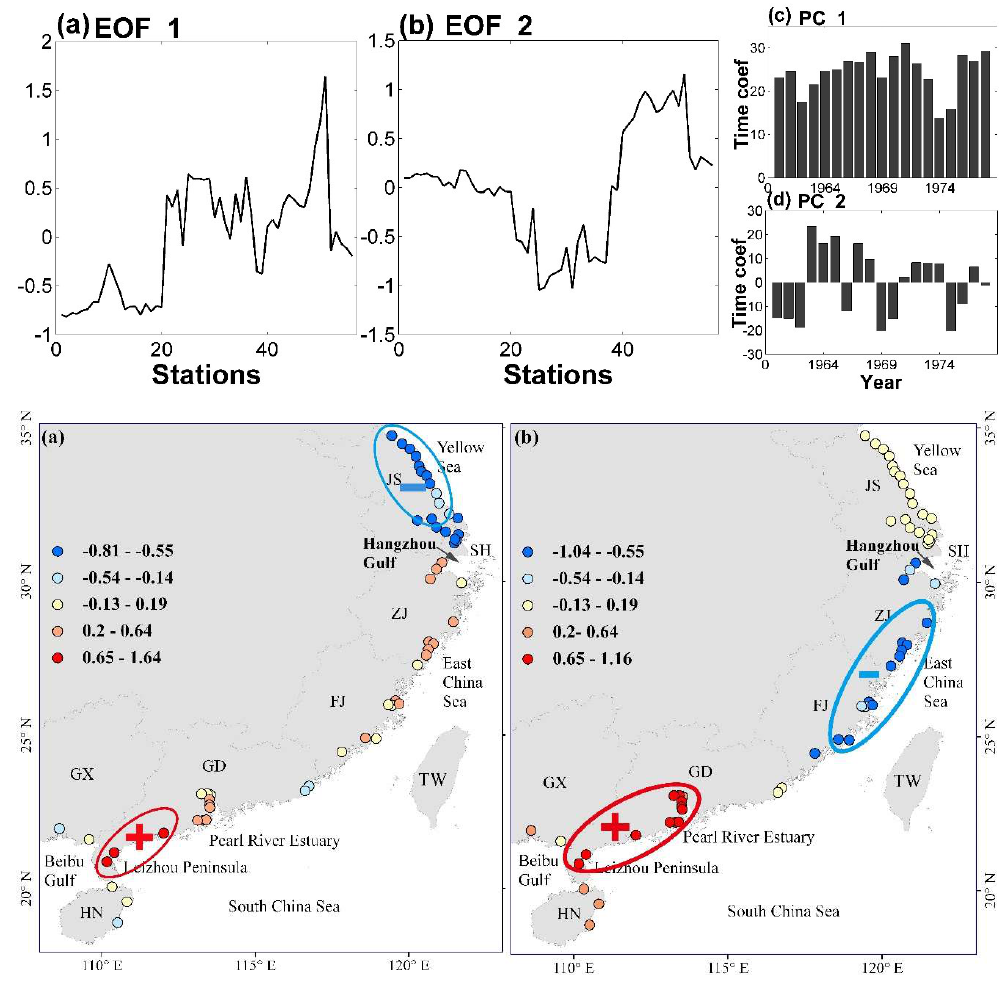
Figure 6. ( a–d ) The first two leading EOF modes and the PCs of ASPI during the period of 1960–1978